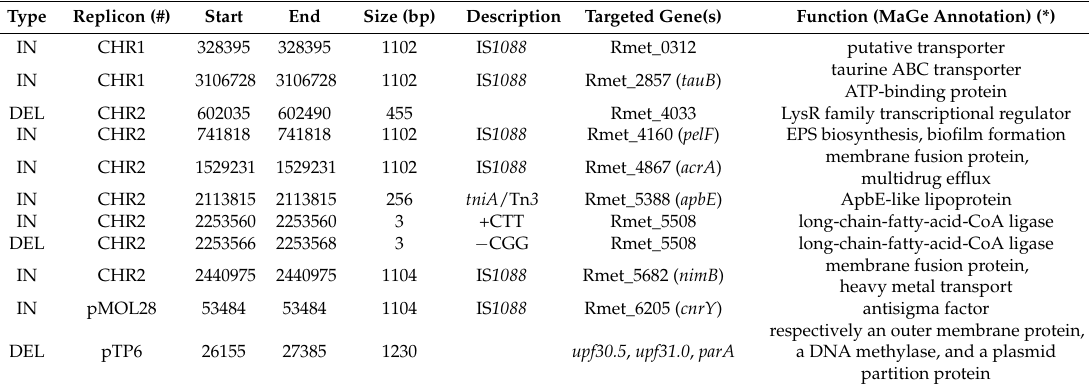
Table 2. Insertions (INs) and deletions (DELs) present in the genome of C. metallidurans